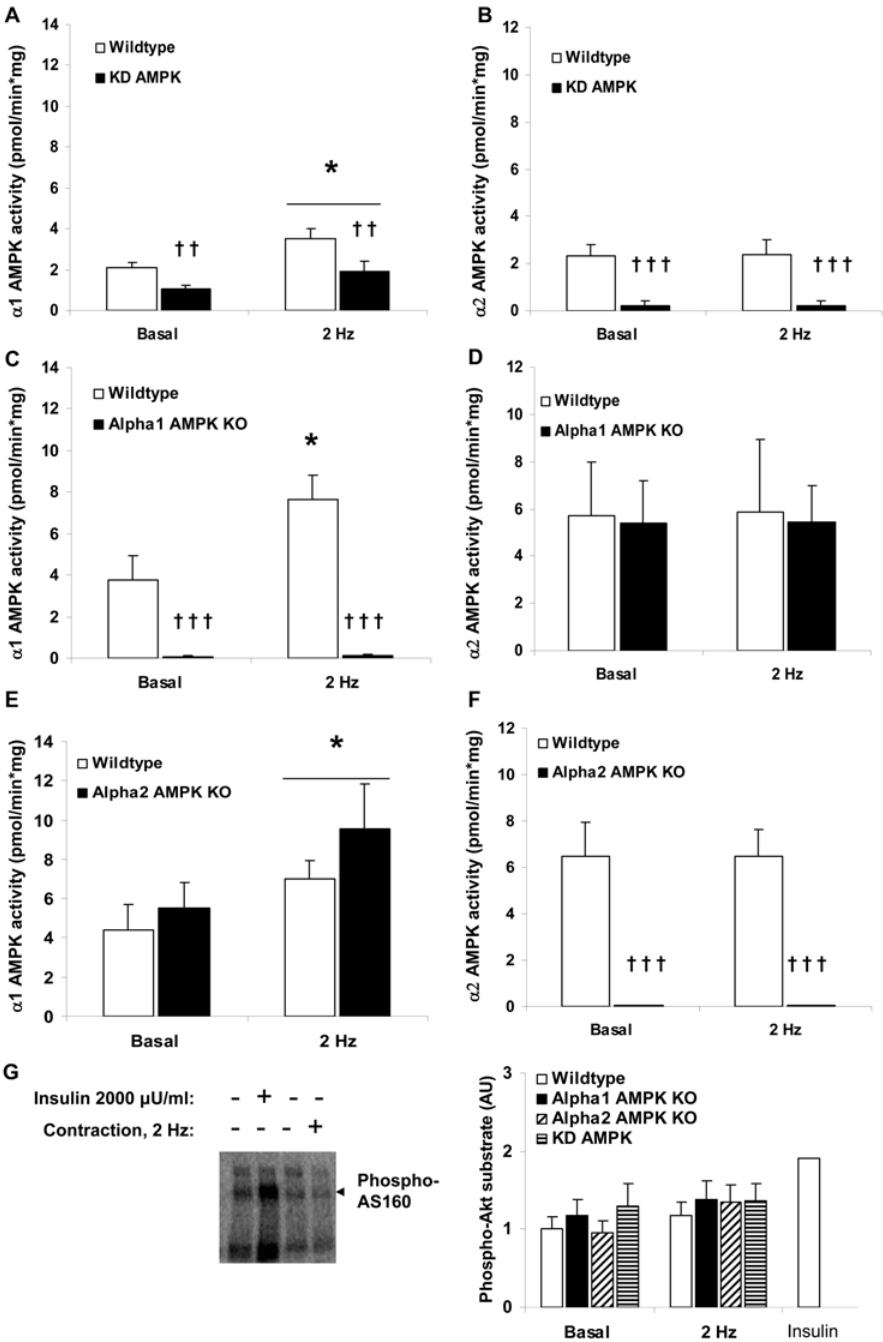
Figure 3. Twitch-contraction (0.1 ms, 2 Hz, 2 min) signaling in AMPK transgenic soleus muscles. A) a 1 AMPK and B) a 2 AMPK activities in wildtype vs. kinase-dead (KD) AMPK muscles (n=7–8), C ) a 1 AMPK and D) a 2 AMPK activities in wildtype vs. a 1 AMPK KO muscles (n=7–10), E ) a 1 AMPK and F) a 2 AMPK activities E) and F) wildtype vs. a 2 AMPK (n=10). G) Basal and twitch-stimulated AS160 phosphorylation in wildtype vs. AMPK transgenic muscles (n=6–9). As a positive control, insulin-stimulated (2000 m U/ml, 15 min) soleus was included (n=1). * p , 0.05 vs. basal. {{ / {{{ p , 0.01/0.001 genotype main effect.